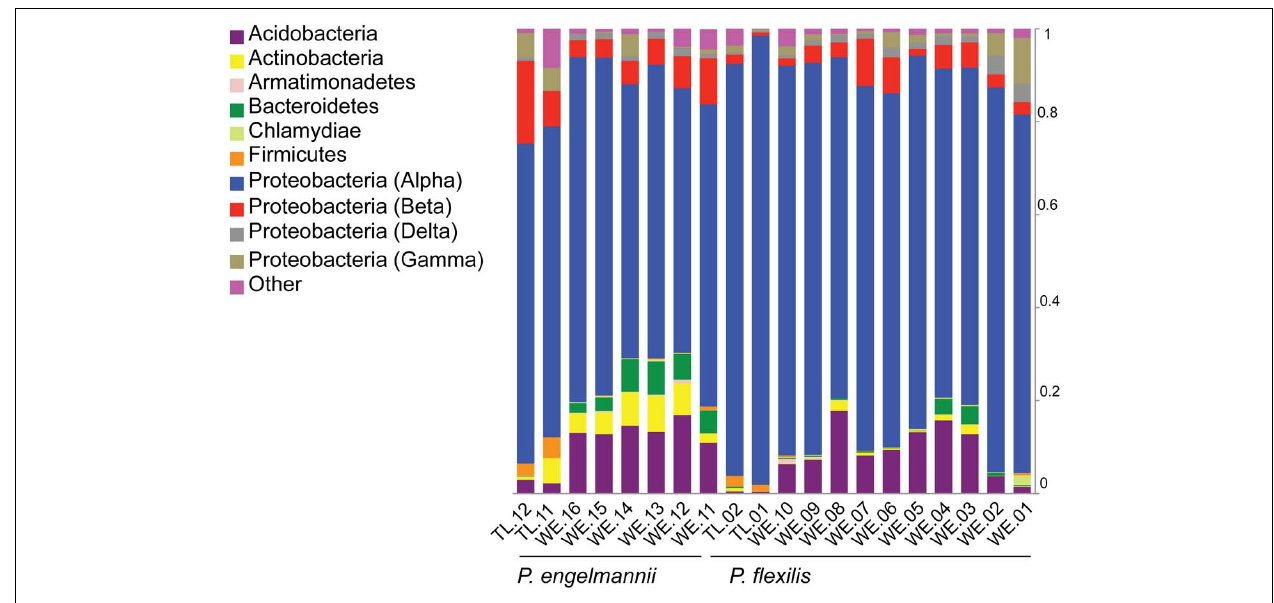
FIGURE 2 | Relative abundances of various major bacterial phyla and classes recovered from P. flexilis and P. engelmannii needles. Relative abundance of phyla (and classes of the Proteobacteria) was